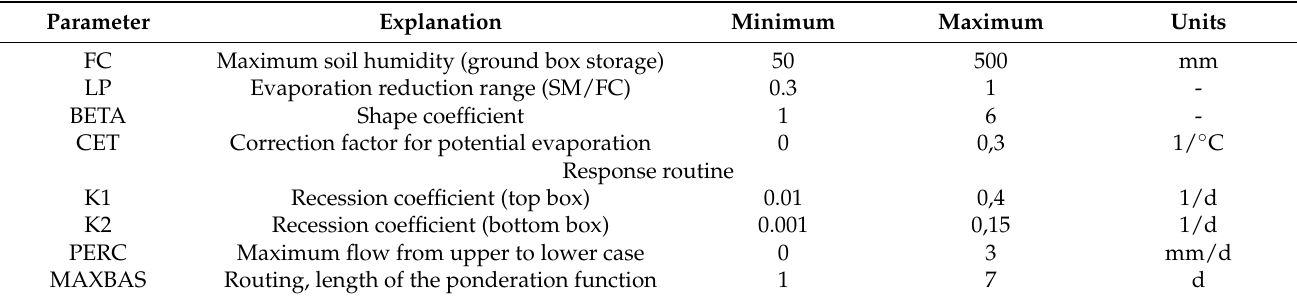
Figure 1. Location of the study and sampling points, protected wildlife areas, and subdivision of watersheds on the Pejibaye River basin, Cartago, Costa Rica. Table 1. Range of parameters used for the calibration of the hydrological